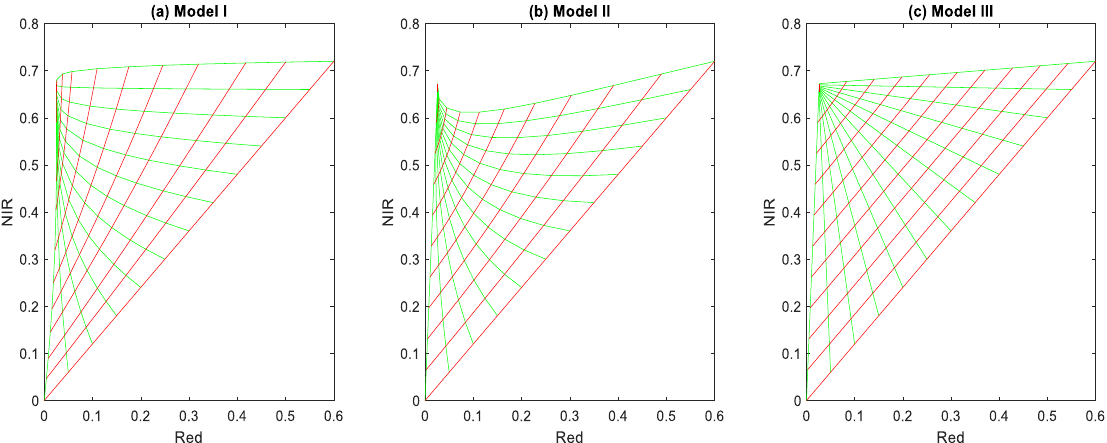
Figure 6. Effects of changes in soil brightness (in red) and the crown LAI, C v and f C (in green) in the red–NIR BHR feature space. Soil brightness ( R s ) levels of 0, 0.05, …, 0.6; LAI levels in panel ( a ) are 0, 0.1, 0.2, 0.35, 0.5, 0.7, 1, 1.5, 2, 4, 8; C v levels in panel ( b ) are 0, 0.1, …, 1.0; f C levels in panel ( c ) are 0, 0.1, …, 1.0. The NIR/red ratio for the soils, S , is assumed to be 1.2. For models II and III, the crown LAI is always 8.